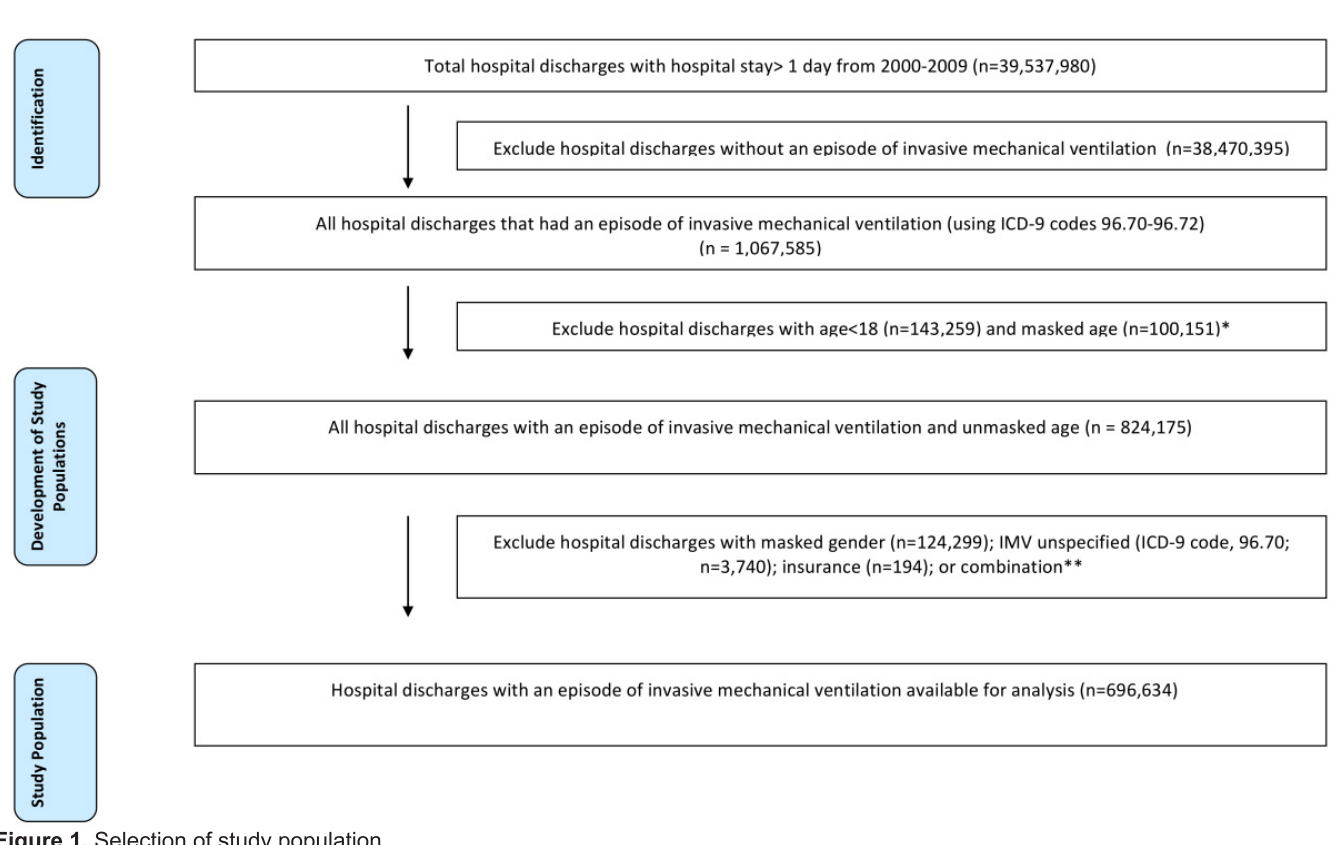
Figure 1. Selection of study population. IMV, invasive mechanical ventilation; ICD-9, International Classification of Diseases 9 th Revision *Number of IMV unspecified discharges (n=569). **Some patients with IMV unspecified (ICD-9 code:96.70) also had missing gender or some combination of those three variables (IMV time, gender, and